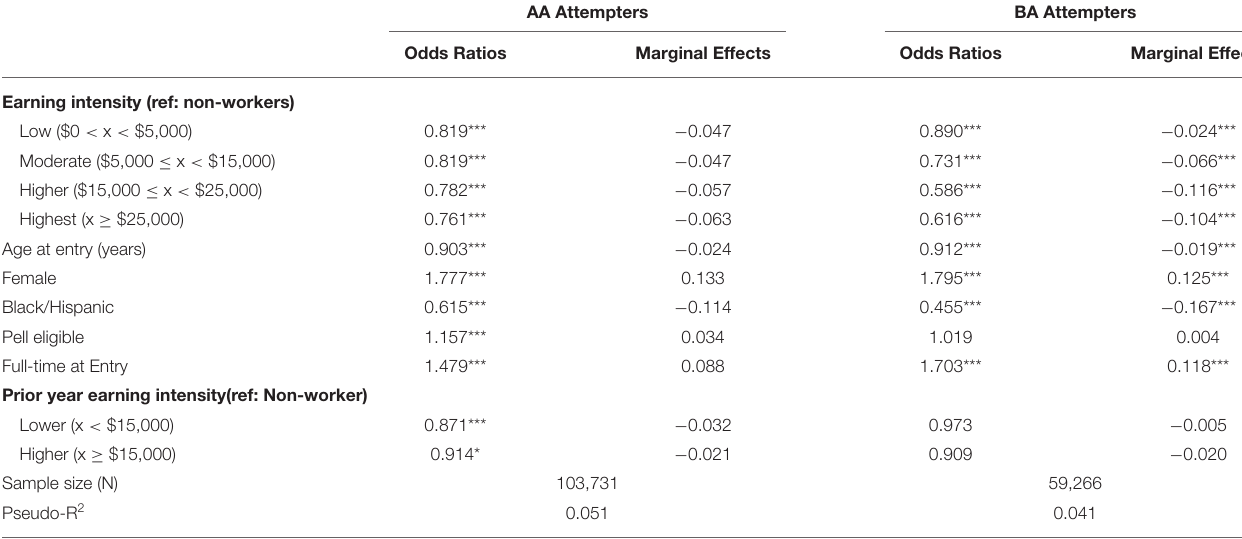
TABLE 3 | Working during college and students’ probability of graduation, Logistic Regression—odds ratios, and marginal effects. AA Attempters BA Attempters Odds Ratios Marginal Effects Odds Ratios Marginal